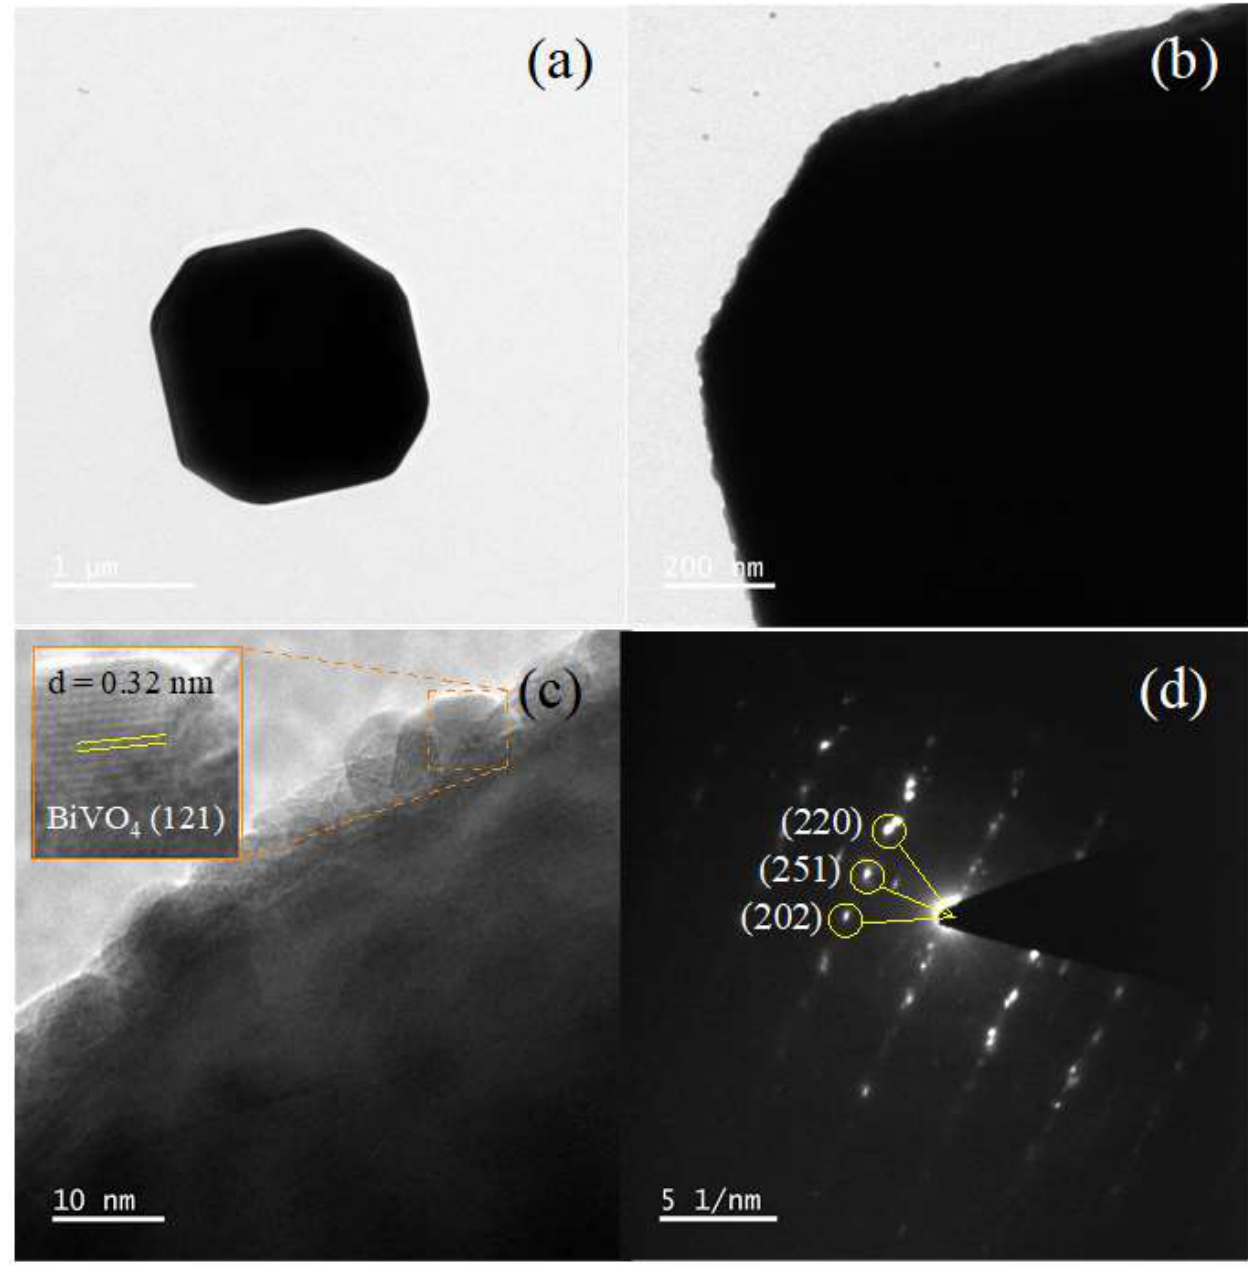
Figure 3. TEM micrographs ( a , b ), HR-TEM micrograph ( c ), and SAED pattern ( d ) obtained from the